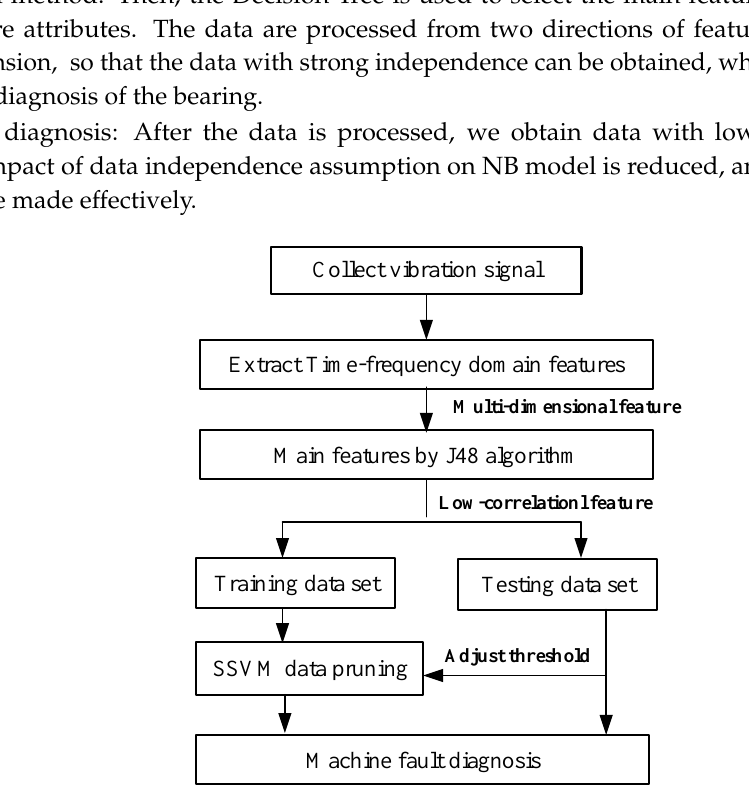
Figure 2. Fault diagnosis model based on the enhanced independence of